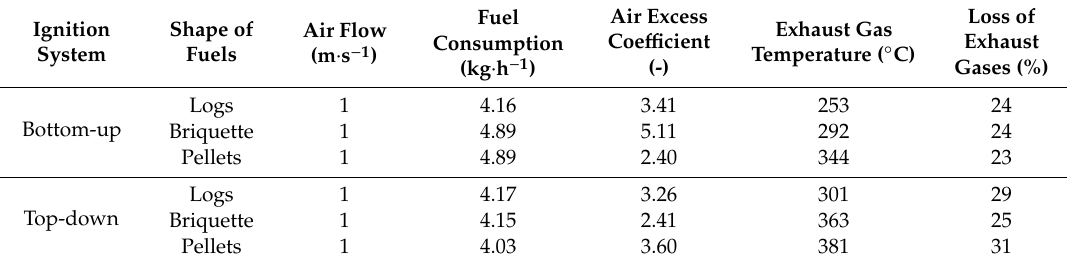
Table 2. Physical parameters of the combustion